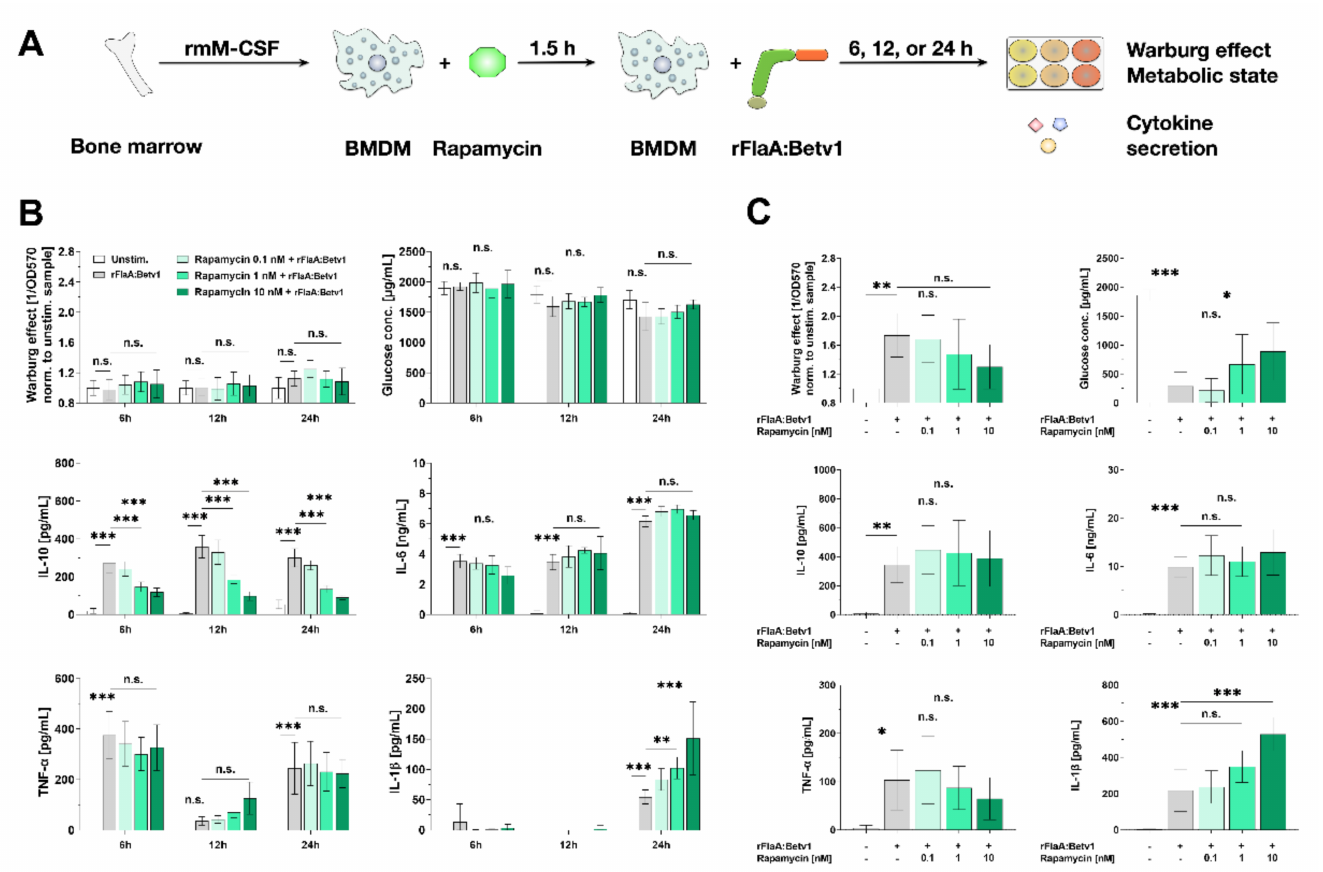
Figure 5. rFlaA:Betv1-induced activation of C57BL/6 BMDM metabolism and IL-10 secretion are partly mTOR-dependent, while pro-inflammatory cytokine secretion is mainly mTOR-independent. C57BL/6 BMDMs were differentiated from mouse bone marrow, pre-treated with the indicated rapamycin (mTOR inhibitor) concentrations for 90 min, and subsequently stimulated with rFlaA:Betv1 for an additional 6, 12, 24, or 96 h ( A ). Cells were analyzed for their metabolic state and cytokine secretion by ELISA after either 6 to 24 h ( B ) and 96 h ( C ). Data are mean results of three independent experiments ± SD, with two technical replicates per experiment. Statistical significance indicated as: n.s. p -value > 0.05, * p -value < 0.05, ** p -value < 0.01, *** p -value <